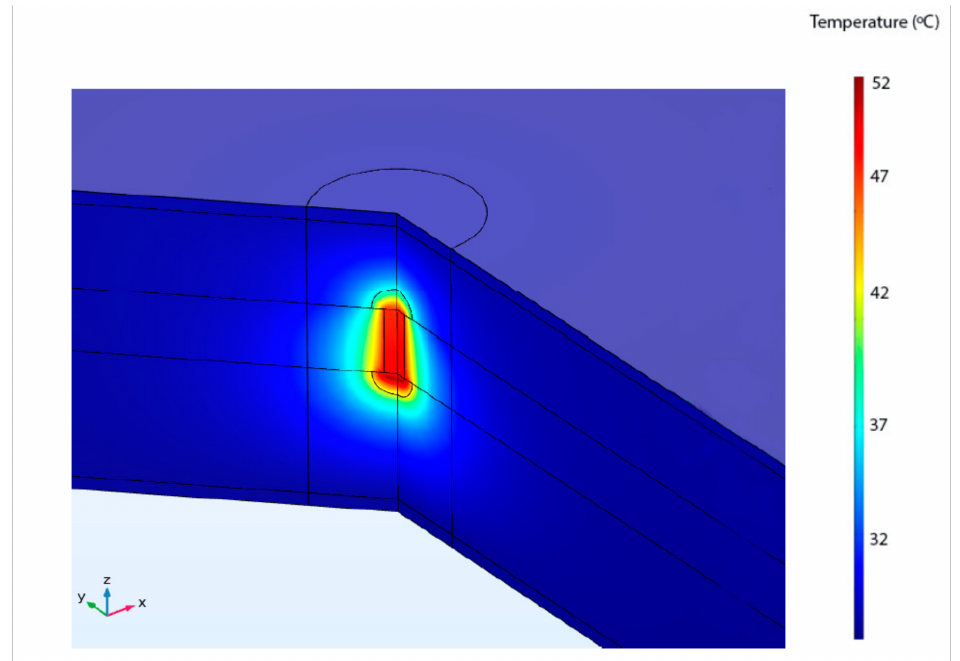
Figure 4. Internal short-circuit in LiFePO 4 battery resulting in thermal